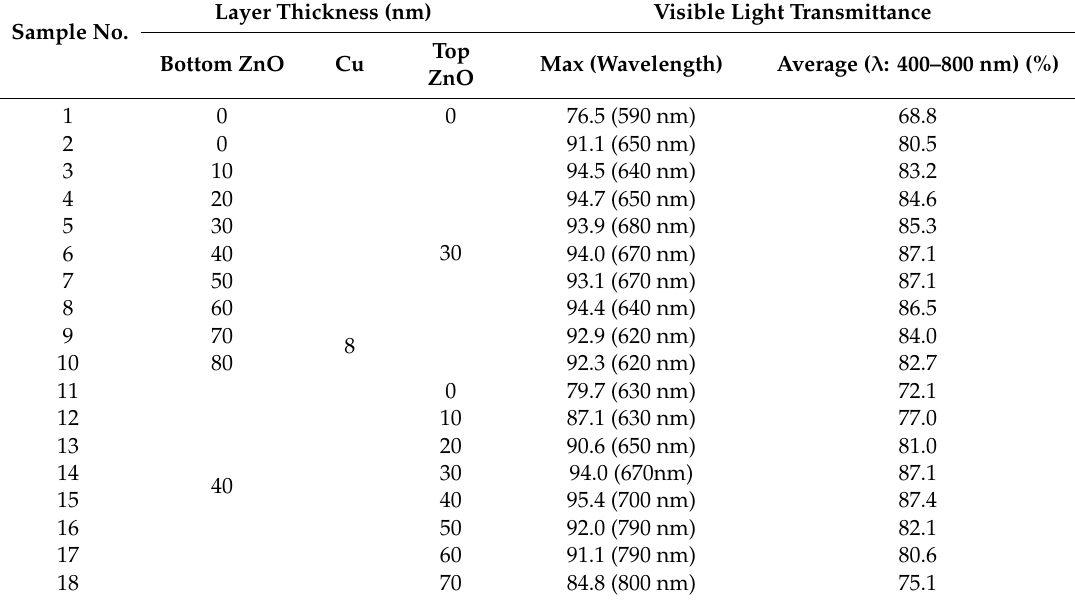
Table 1. Sample number, layer thicknesses of the bottom ZnO, Cu and top ZnO. The maximum transmittance values with the corresponding wavelengths and the average visible light transmittance values are presented, for which the transmission loss for the glass substrates was excluded. Layer Thickness Sample No.